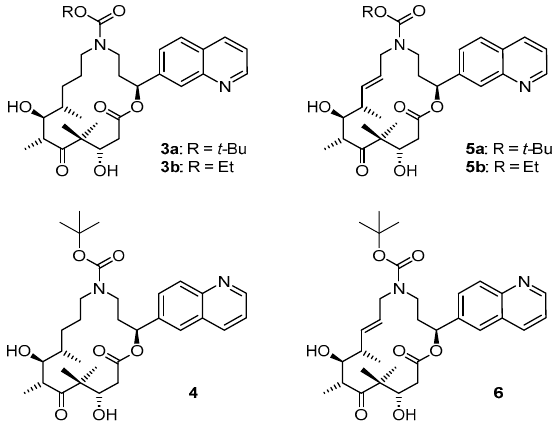
Figure 2. Molecular structures of azathilones investigated in this study.